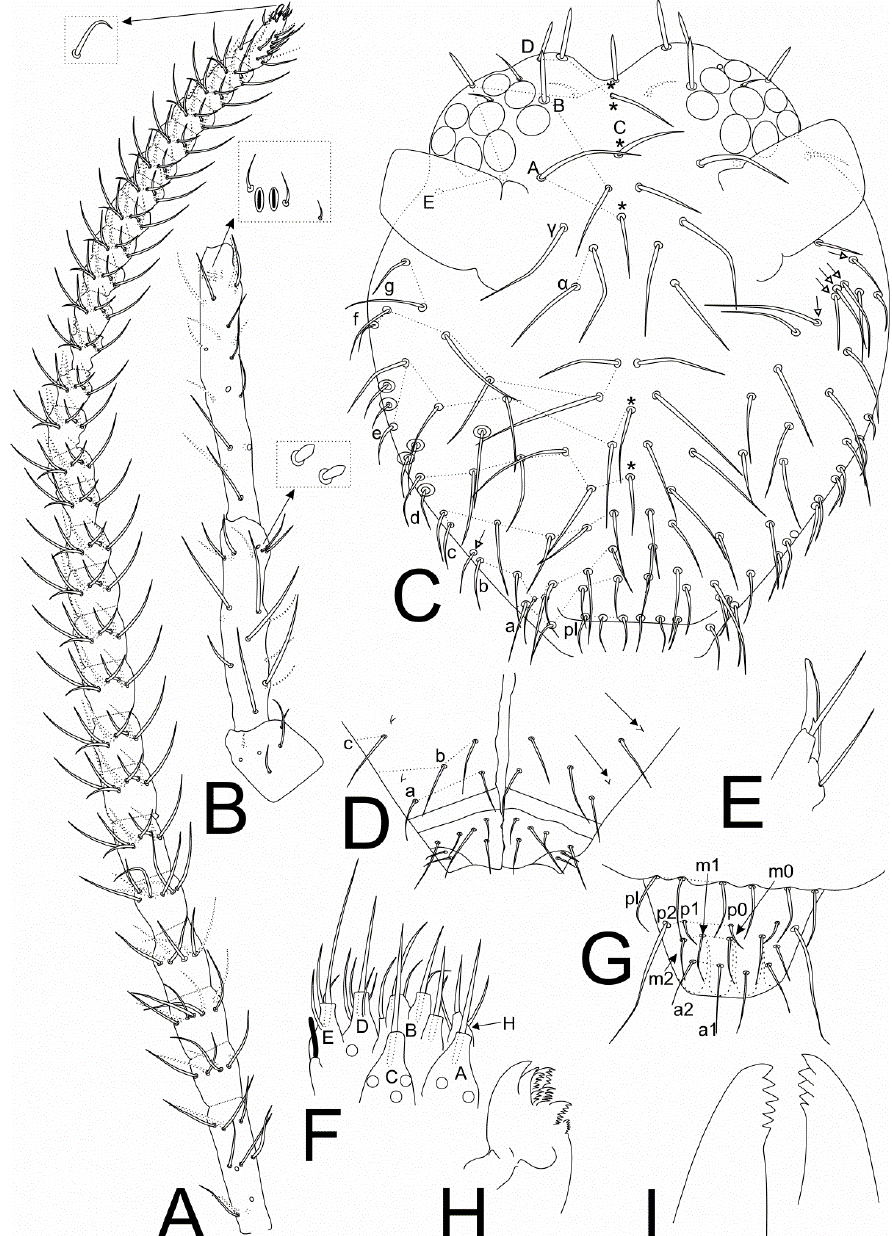
Figure 1. Richardsitas subferoleum sp. nov. head: ( A ) left Ant IV, arrow points to apical curved chaeta; ( B ) left Ant I–III, arrow on Ant II points to two modified apical sensilla, arrow on Ant III points to apical organ of Ant III; ( C ) frontal head chaetotaxy, circles = extra chaetae without clear homologies, * = unpaired chaetae, white arrows point to chaetae present or absent; ( D ) ventral head chaetotaxy, arrows point to cuticular spines; ( E ) right maxillary outer lobe and sublobal plate; ( F ) labial palp papillae (left side) and proximal chaetae (circles), lateral process in black; ( G ) prelabral and labral chaetae; ( H ) left maxilla capitulum; ( I ) right and left apices of mandibles (incisive teeth).